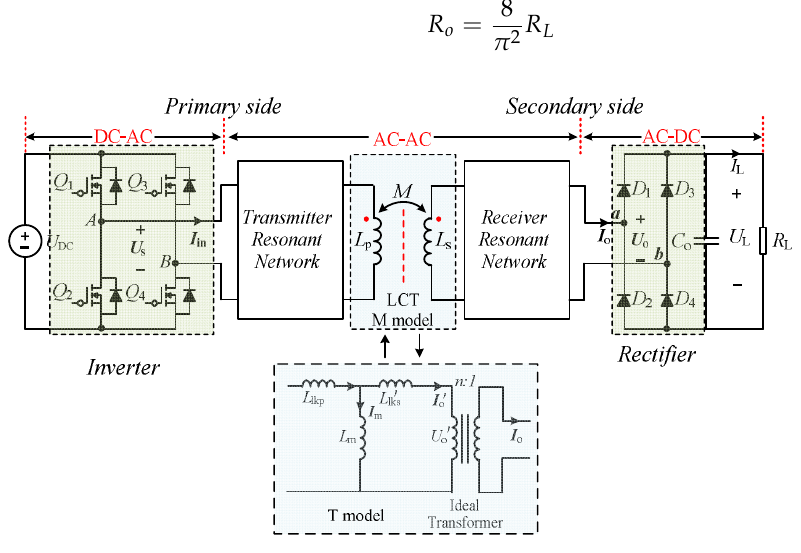
Figure 1. IPT system.